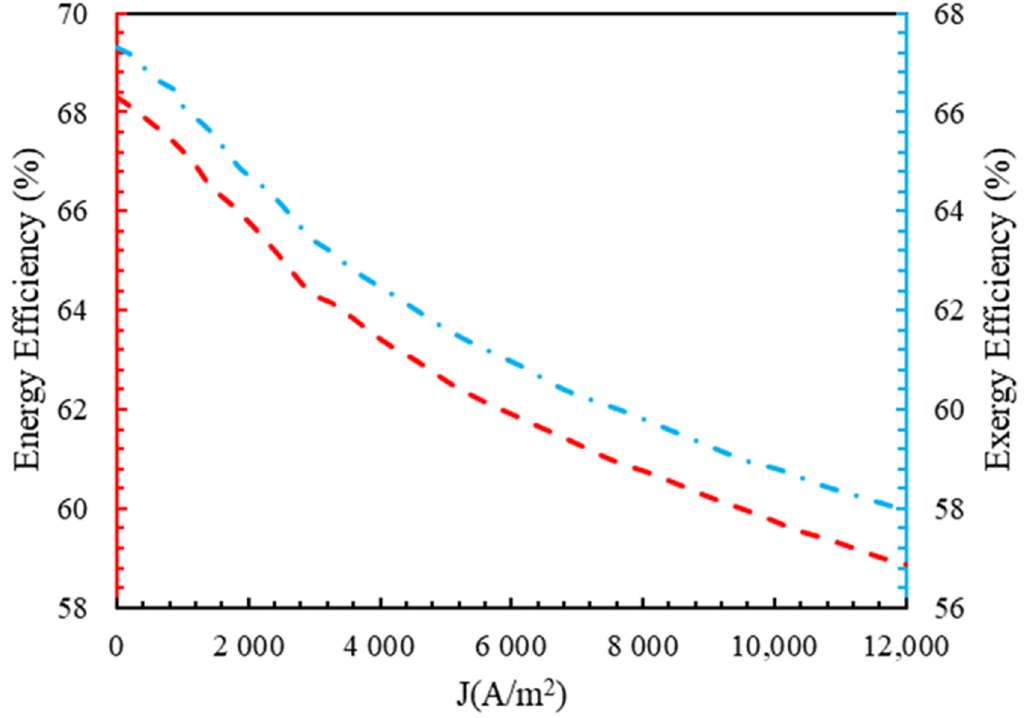
Figure 4. The energy and exergy efficiency of the polymer membrane electrolyzer in terms of current density.